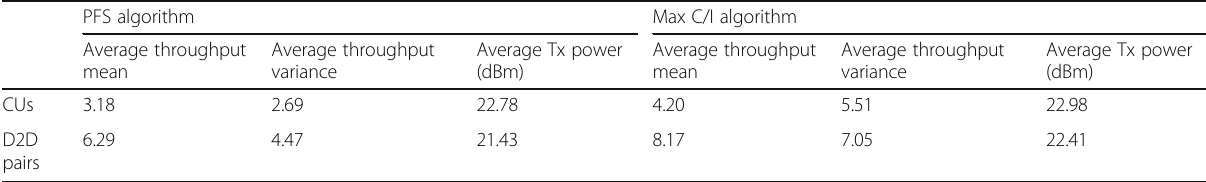
Table 2 Numerical analysis for PFS and max C/I PFS algorithm